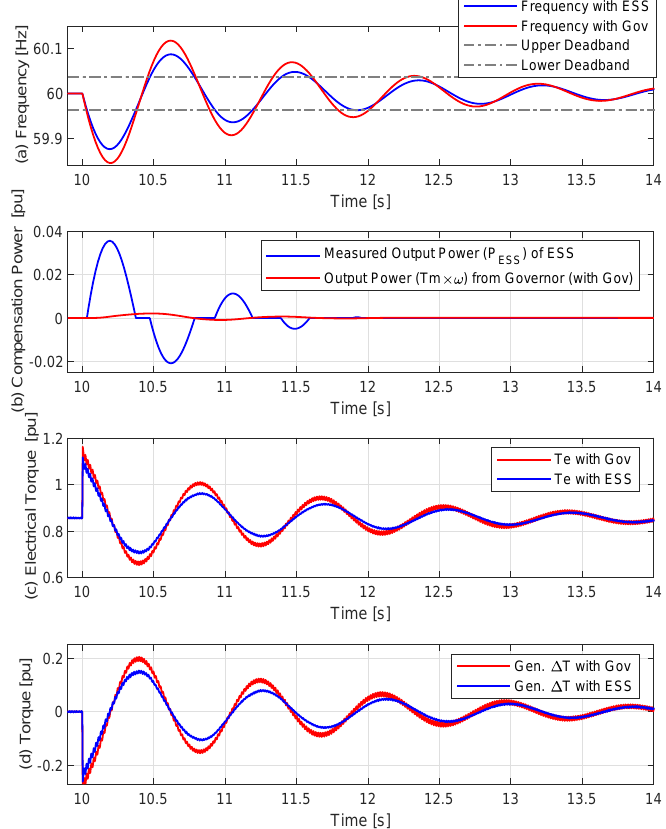
Figure 13. Generator trip case; ( a ) generator frequency, ( b ) output power of ESS and Governor, ( c ) electrical torque of generator, ( d ) torque deviation ( ∆ T = T m − T e ) of generator.